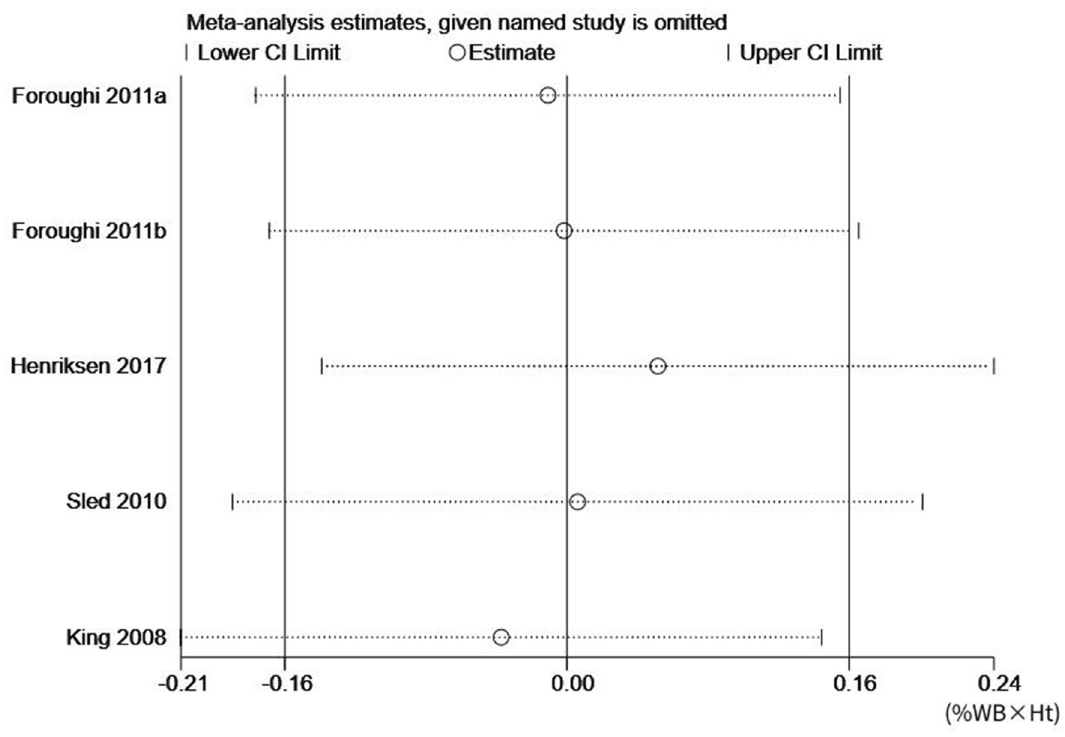
Figure 5. Sensitivity analysis for knee adduction moment (KAM).